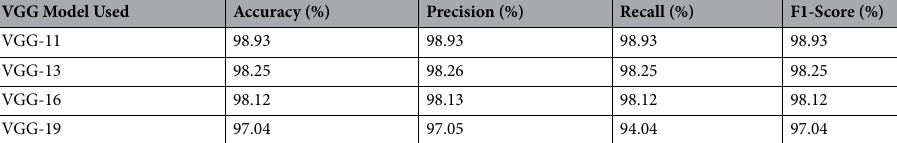
Table 3. Results obtained by the ensemble of WideResNet-50-2 and Inception v3 with varying VGG models on the SARS-COV-2 dataset.